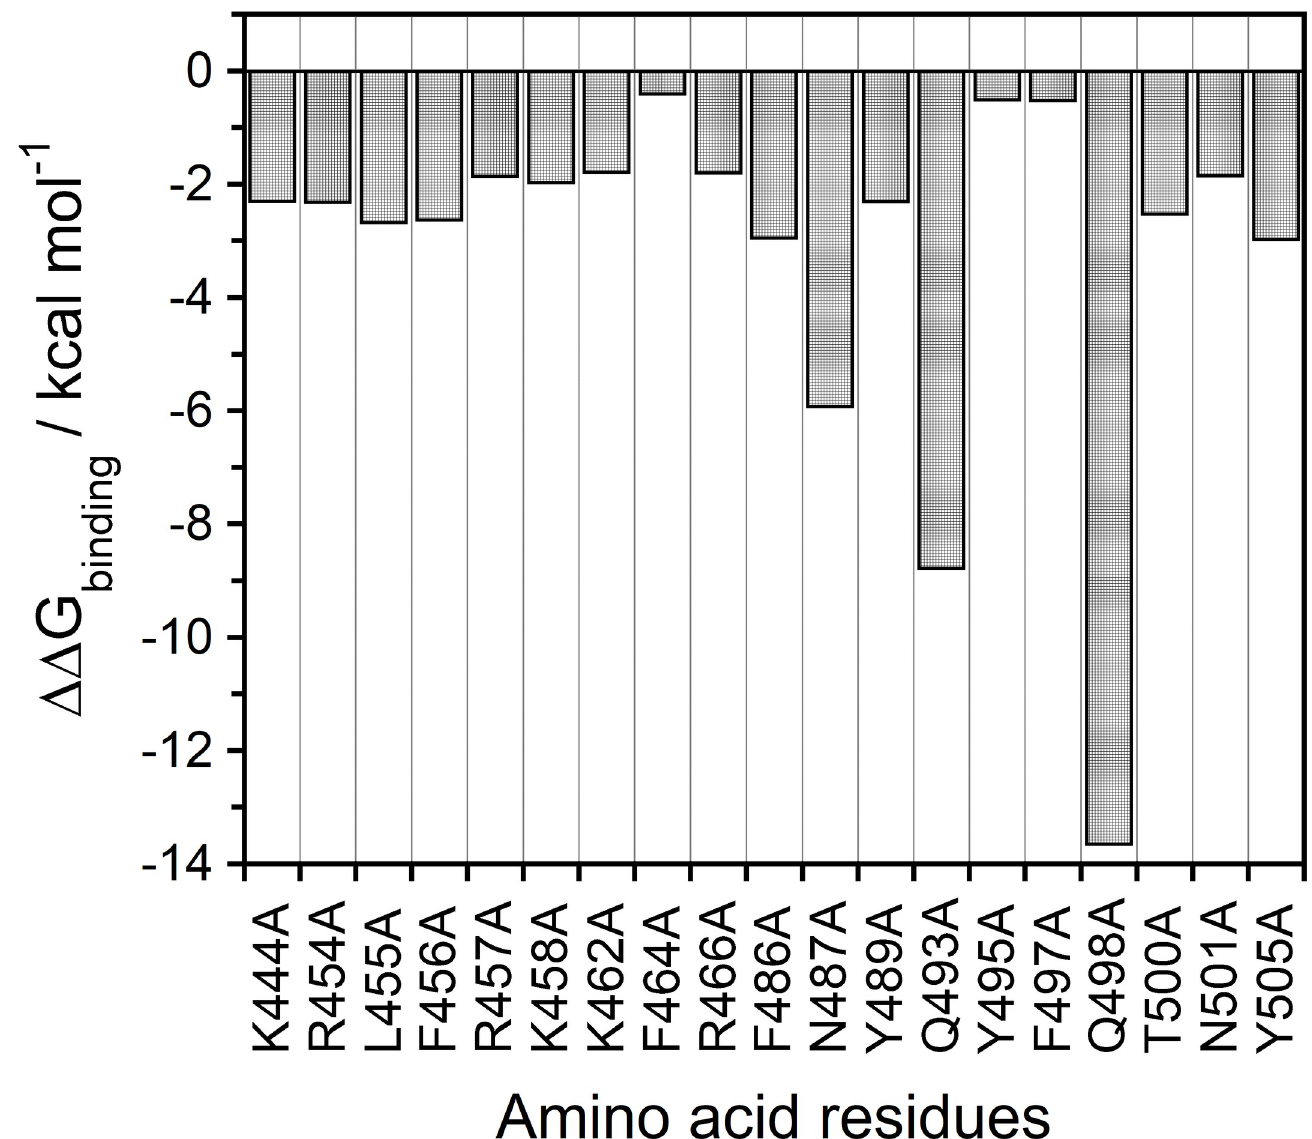
Fig 2. An alanine scanning of spike-RBD binding region in the wild-type SARS-CoV-2 structure over the production phase MD simulations. The binding energy changes ( ΔΔ G binding , kcal mol-1) are reported that demonstrates the relative affect the mutation in each the Δ G of binding complex, ΔΔ G binding = Δ G wild- G . The binding energy for each alanine mutant based on the MM-PBSA method is type − Δ alanine